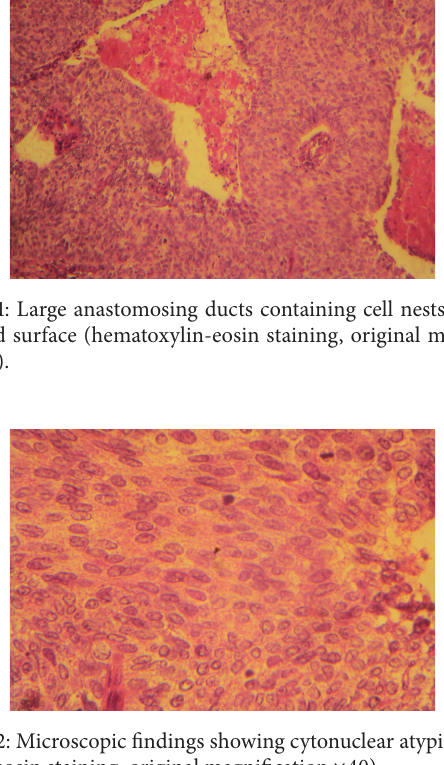
Figure 2: Microscopic findings showing cytonuclear atypia (hema- toxylin-eosin staining, original magnification × 40).